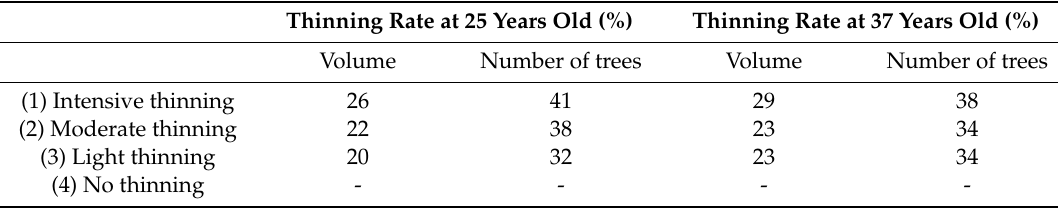
Table 1. Summary of thinning intensities in study plots.